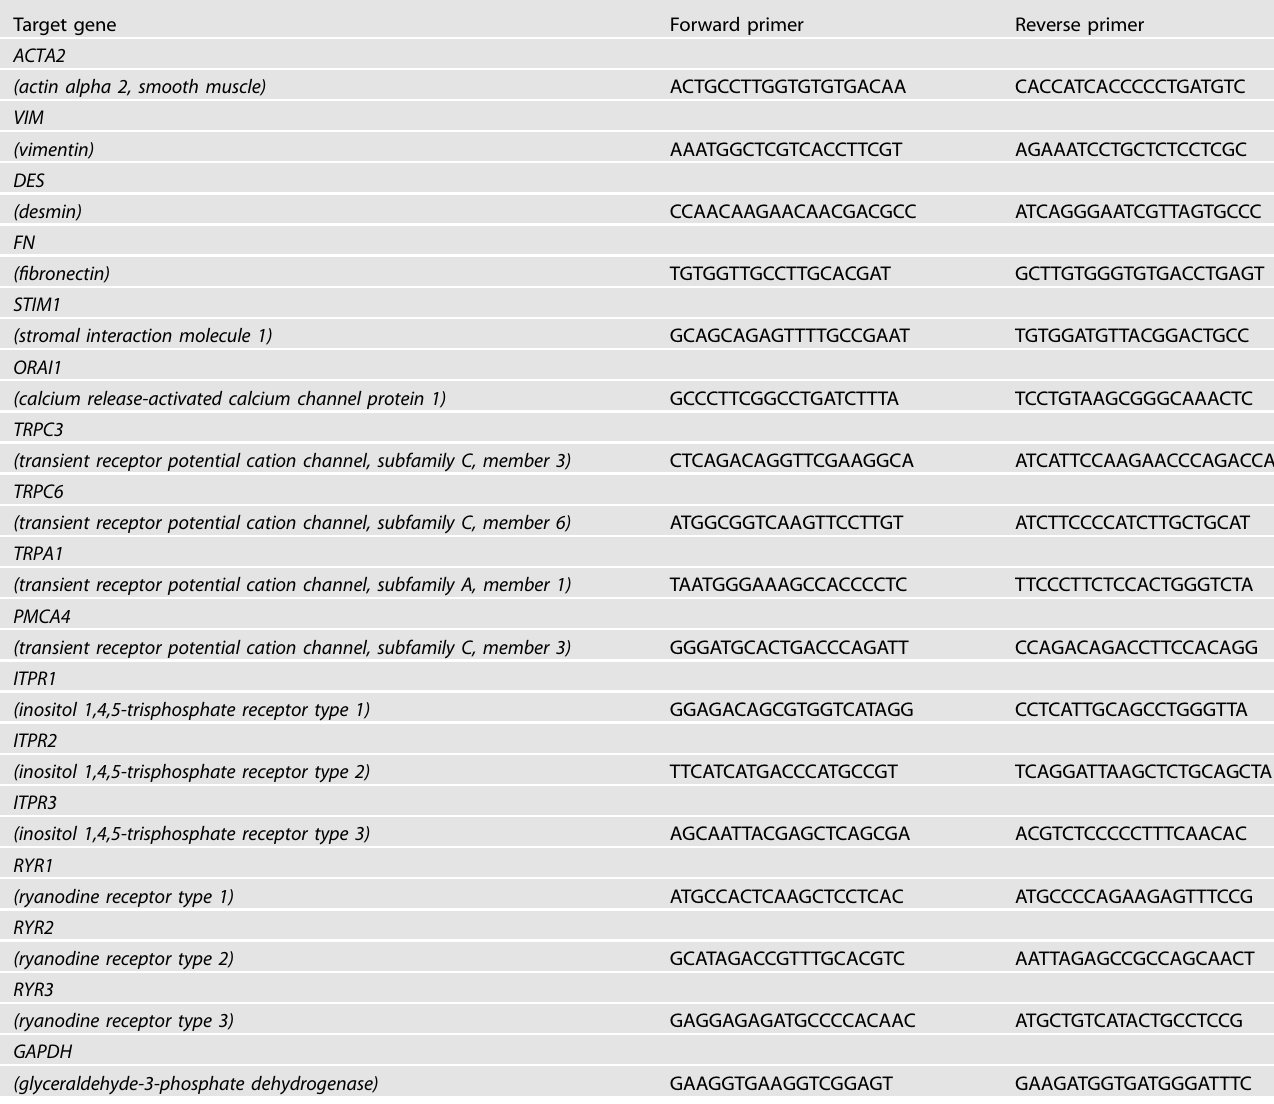
Table 1. List of primer sequences used in real-time PCR experiments. Target